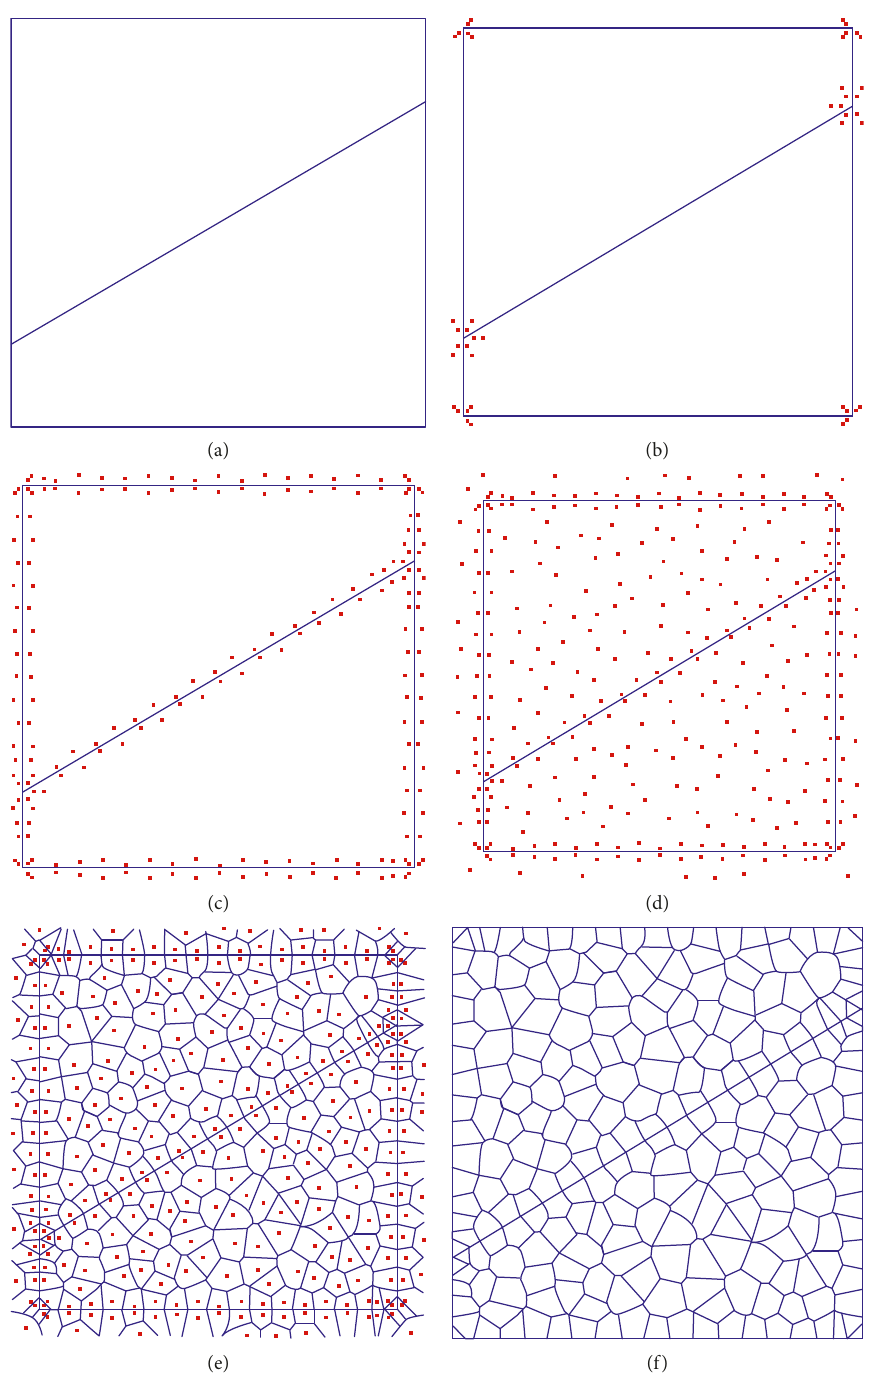
Figure 7: Illustration of mesh generation